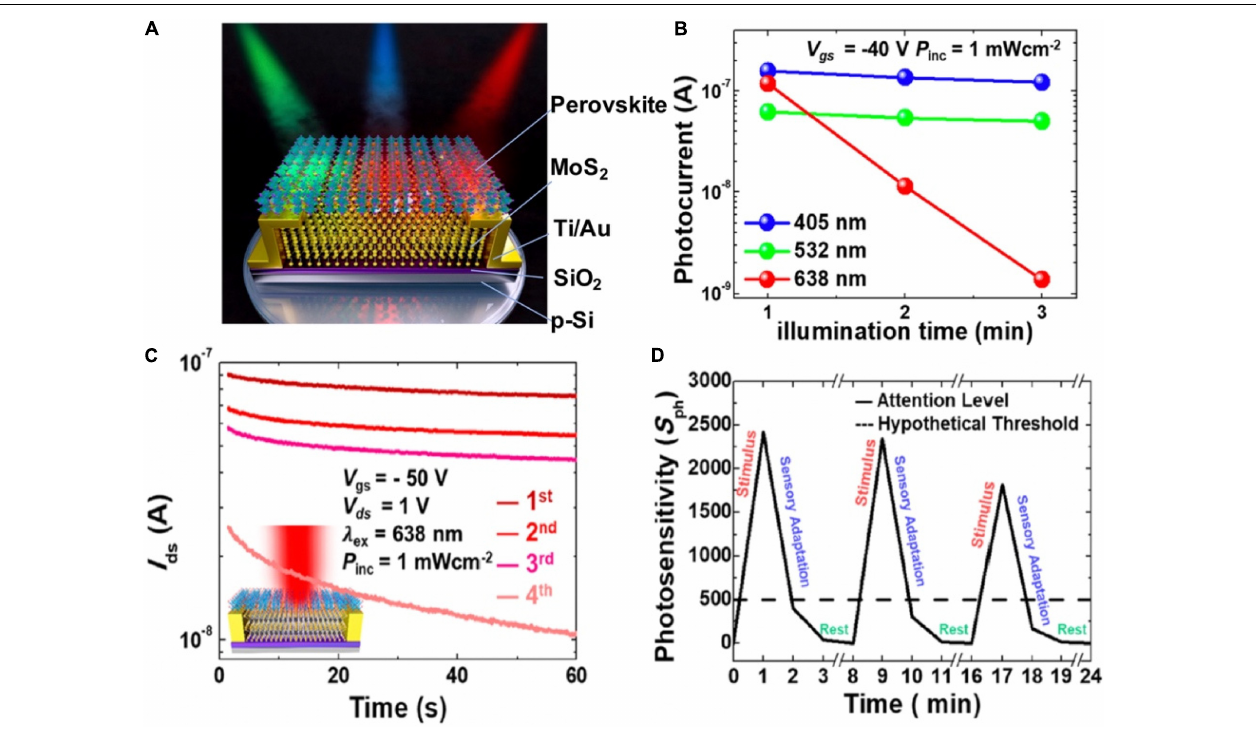
FIGURE 11 | (A) Phototransistor under illumination of blue, green, and red light. (B) Variation trend of photocurrent in the phototransistor under RGB light illumination time. (C) Distinction of the photocurrents in the phototransistor under constant red light illumination with respect to time in four measurement. (D) Photosensitivity of the device during emulating sensory adaptation (adapted from Hong et al.,